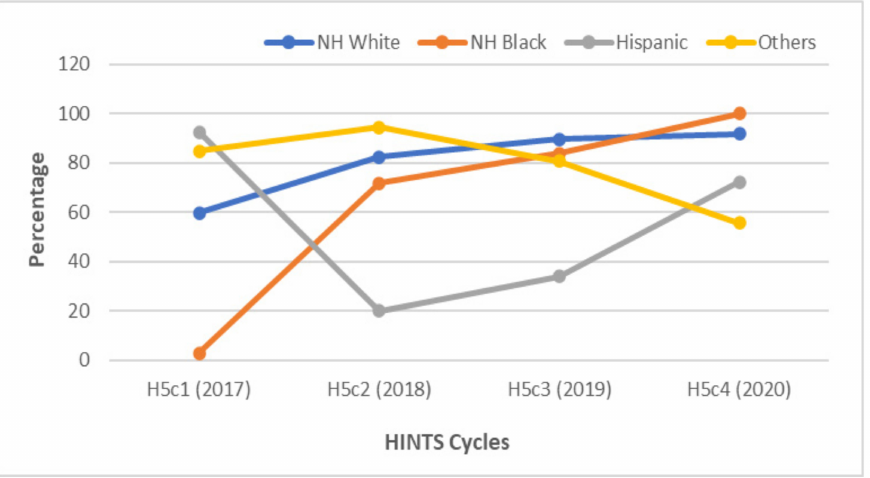
Figure 2. Awareness of HPV among gay and bisexual males according to race/ethnicity between 2017 and 2020. There was a large decrease in awareness about HPV among Hispanic GBM between 2017 and 2018. Annually, non-Hispanic (NH) white and black GBM gained awareness of HPV.